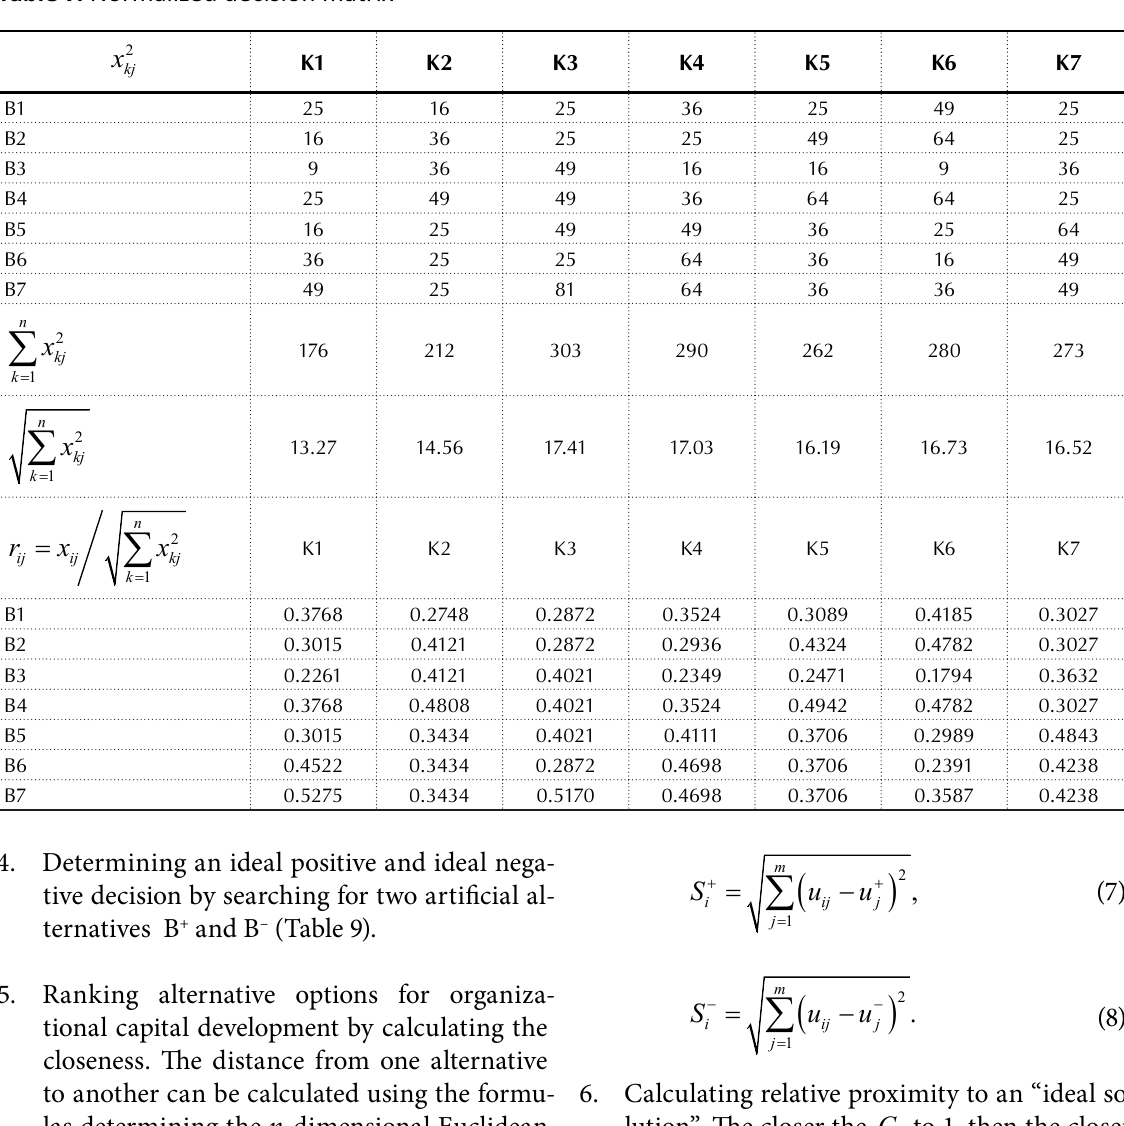
Table 8. Weighted normalized decision matrix